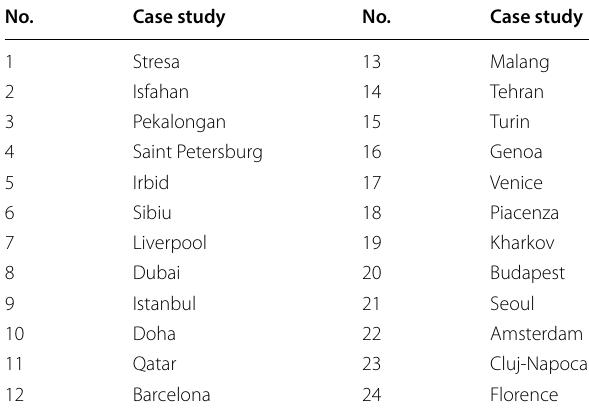
Table 1 The 24 selected case studies based on secondary